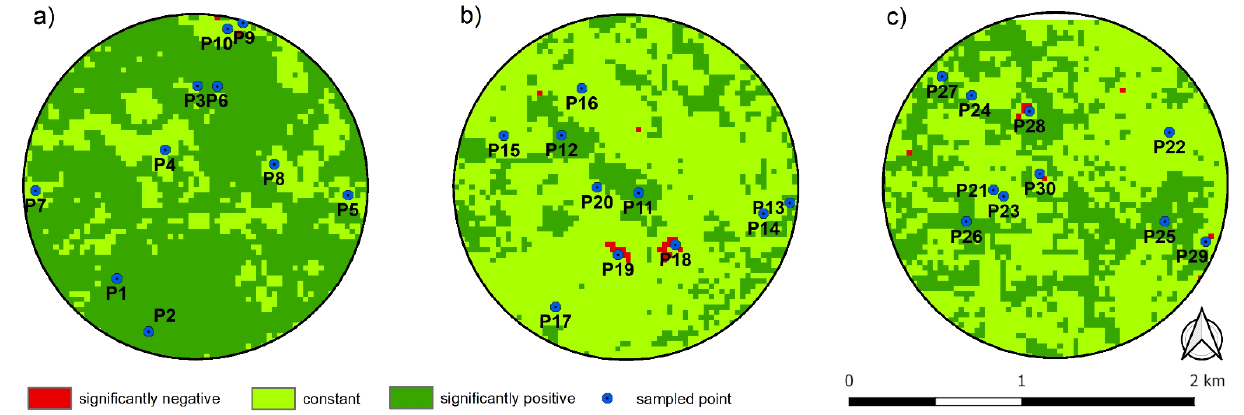
Figure 7. Maps of environmental criticalities and sampled points at the three targeted areas: ( a ) Aia dei Monaci, ( b ) Montegrosso-Pallareta, ( c ) Vallone Calabrese.